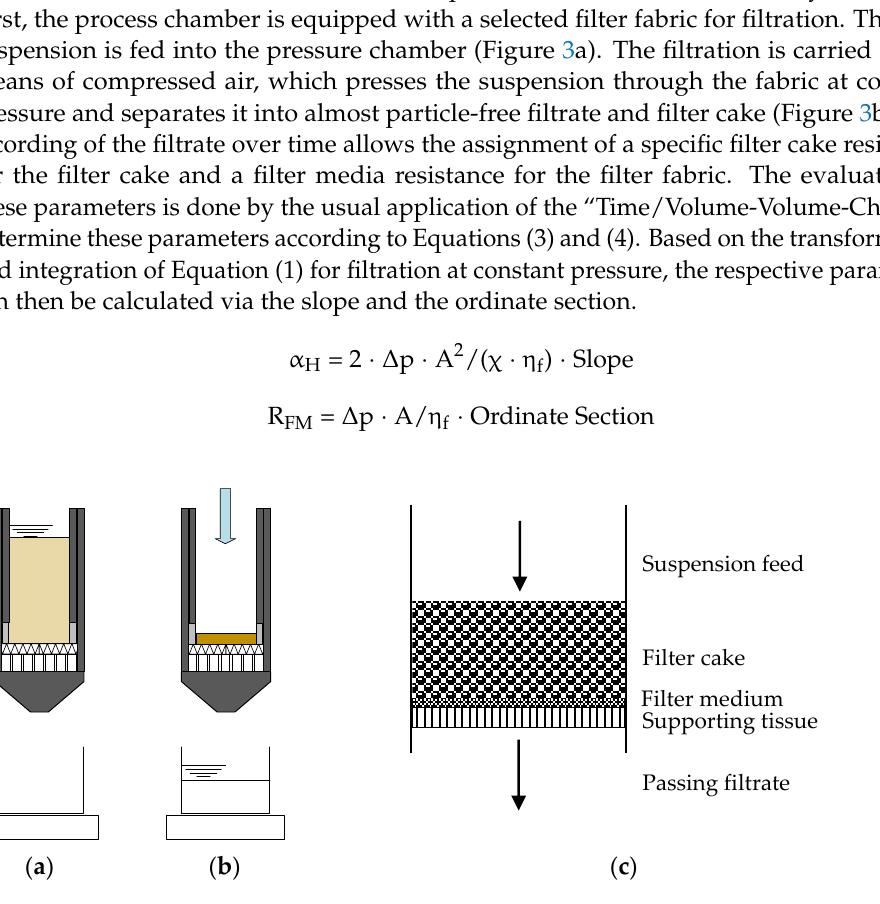
Figure 3. Schematic representation of pressure filtration by means of pressurized filter cell for the suspension feed ( a ), after filtration ( b ) and the schematic structure of the filtration process ( c ). The suspension is separated by a fabric into filter cake and particle-free filtrate.